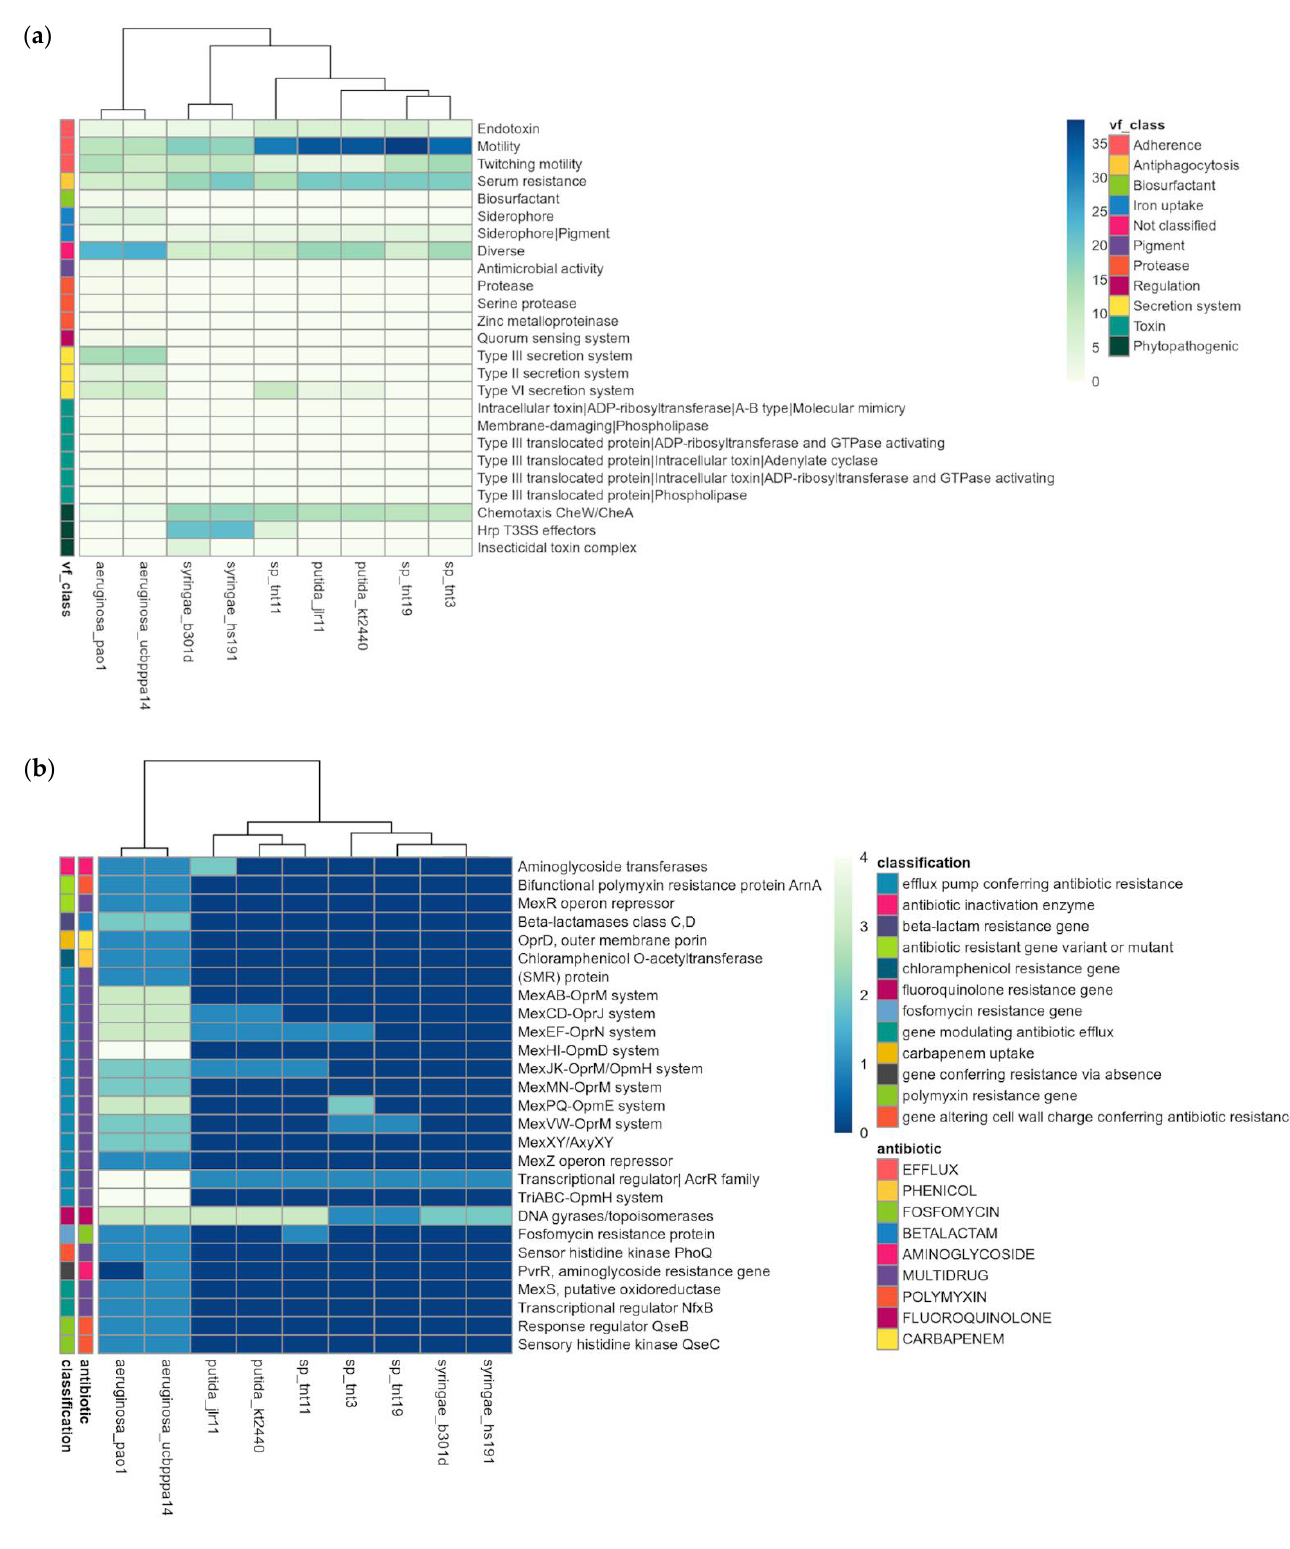
Figure 4. Pathogenic profile of TNT isolates as compared with other pathogenic and non-pathogenic pseudomonads. ( a ) Heat map of putative virulence factors; ( b ) heat map of putative antibiotic resistance genes.